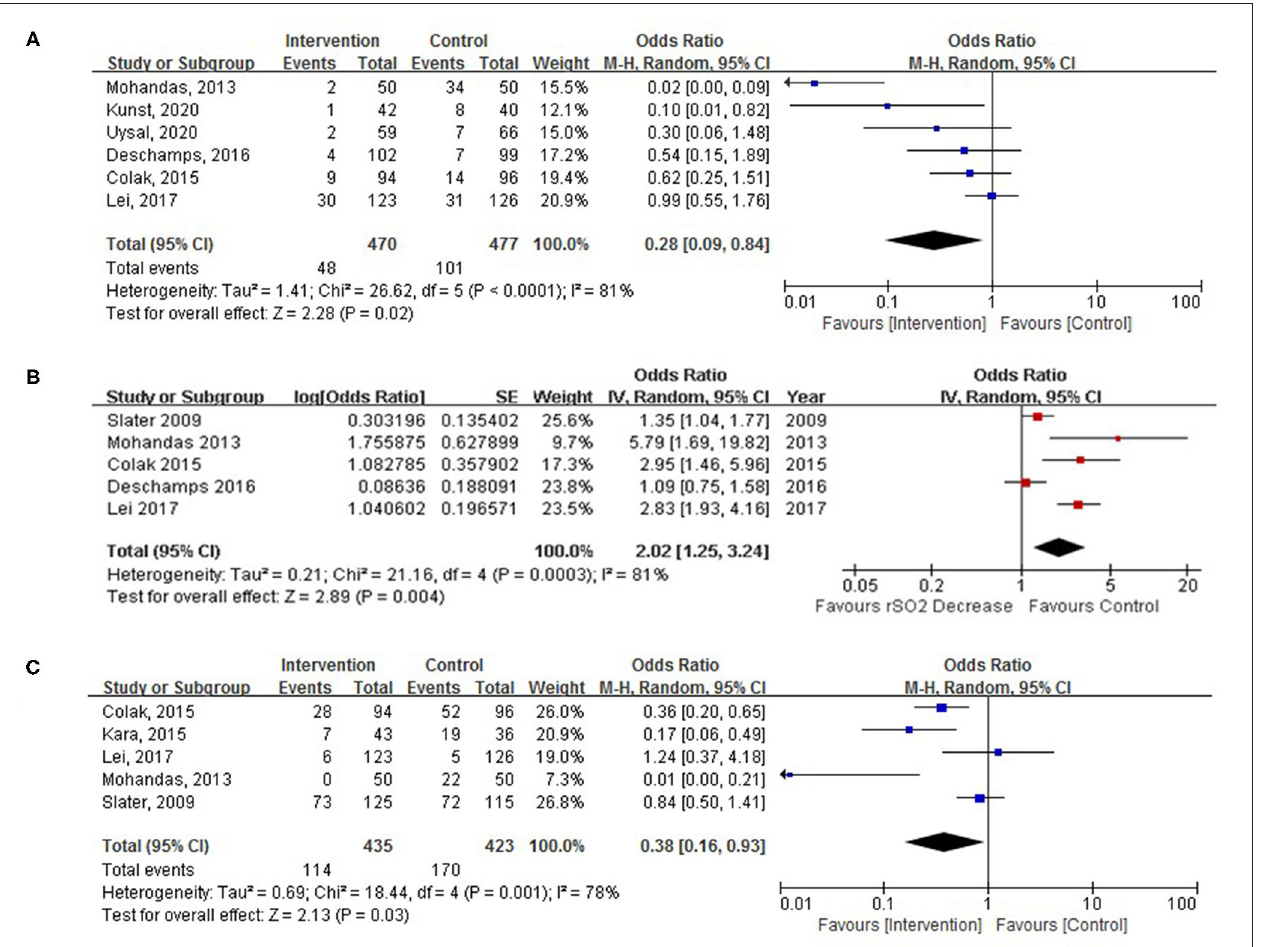
FIGURE 4 | (A) Pooled effect of cerebral oximetry monitoring-guided intervention on the incidence of postoperative delirium (POD). (B) The pooled incidence of POD with cerebral oximetry desaturation. (C) The pooled effect of cerebral oximetry monitoring-guided intervention on the incidence of postoperative cognitive decline